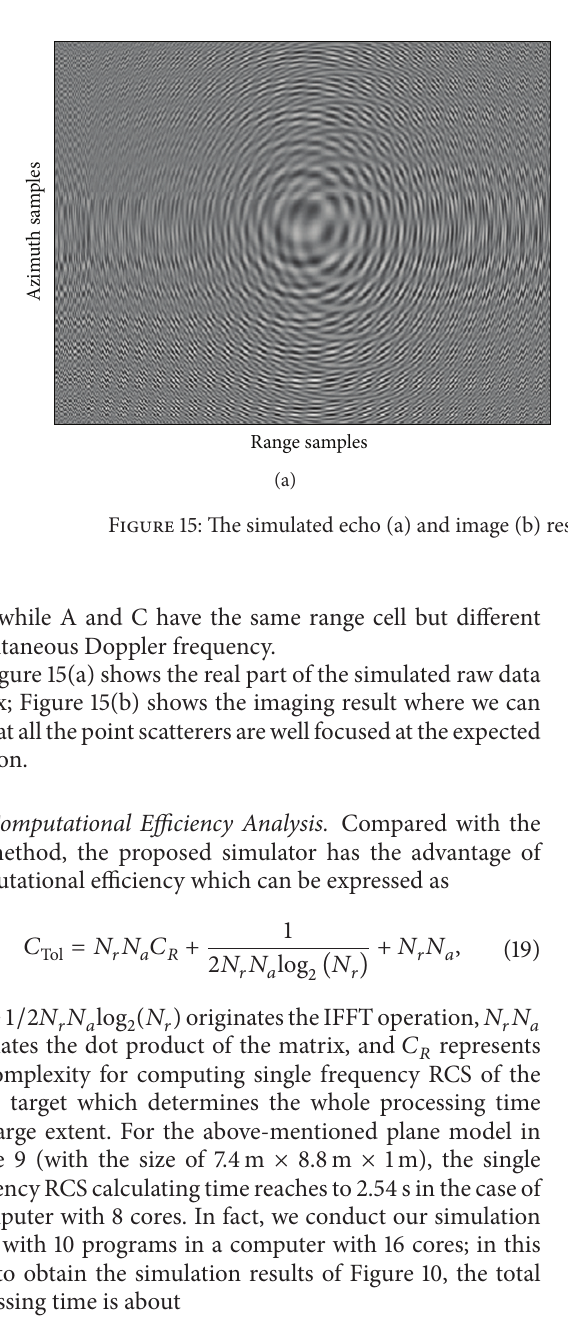
Figure 15: The simulated echo (a) and image (b) results of the plane model in the case of bistatic SAR.